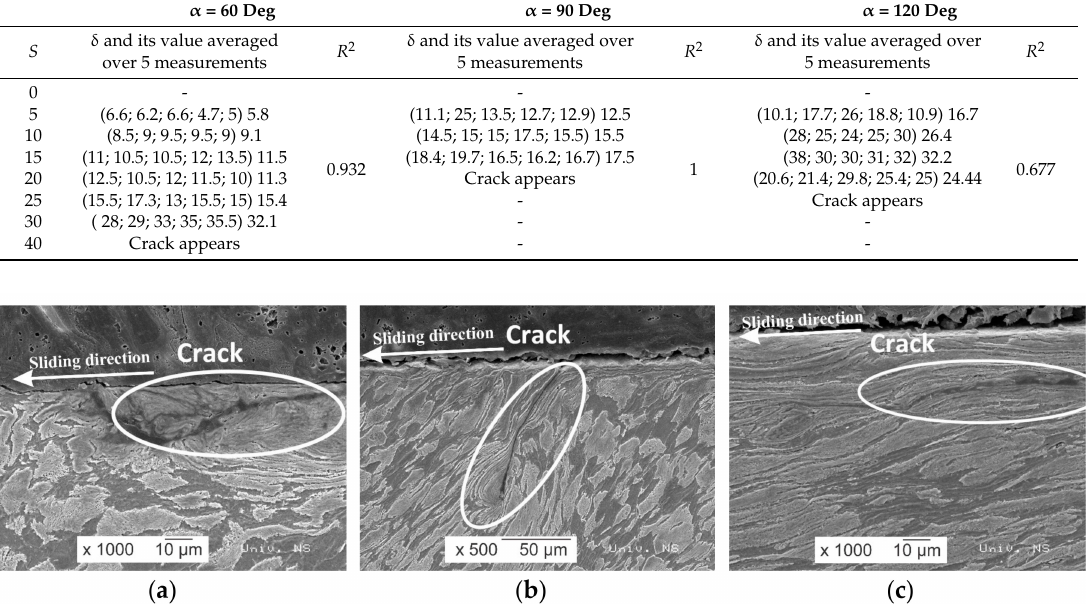
Table 2. Measured values of δ for one specimen of each series.